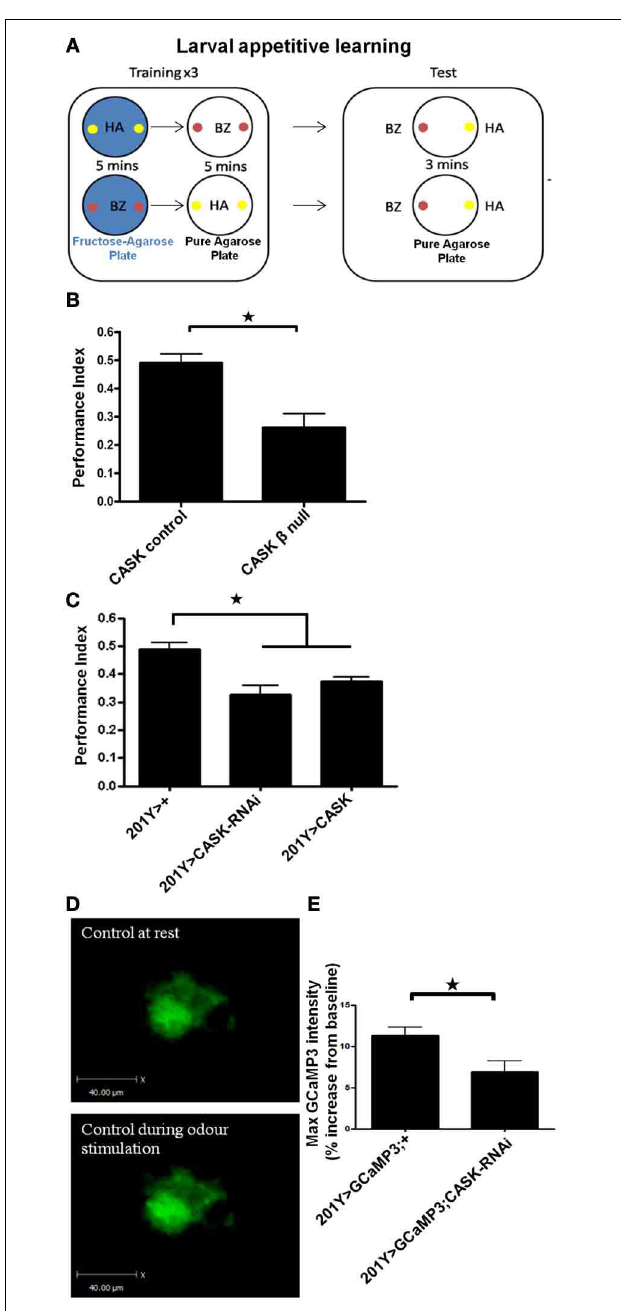
FIGURE 6 | The CaMK-like and L27 domain-containing version of CASK is required for appetitive learning. (A) The role of CASK in associative memory was assessed by a larval olfactory-sugar reward conditioning protocol (Chen et al., 2011) described by the cartoon. The large rounded square on the left depicts the training phase of the protocol. Larvae were sequentially placed on petri dishes, represented by the large black circles, that contained either pure agarose (white filled circles) or 2M fructose agarose (blue filled circles, the unconditioned stimulus, US). At the same time, the larvae were exposed to one of two neutral odors (the conditioned stimulus, CS). In the example given (top row) the larvae received 5min of hexyl acetate on fructose-agarose (HA, small yellow filled circles, CS + ) and then 5min of benzaldehyde on agarose alone (BZ, small red